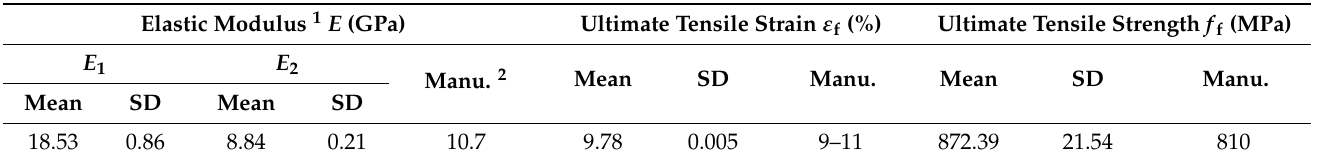
Table 2. Material properties of PET.